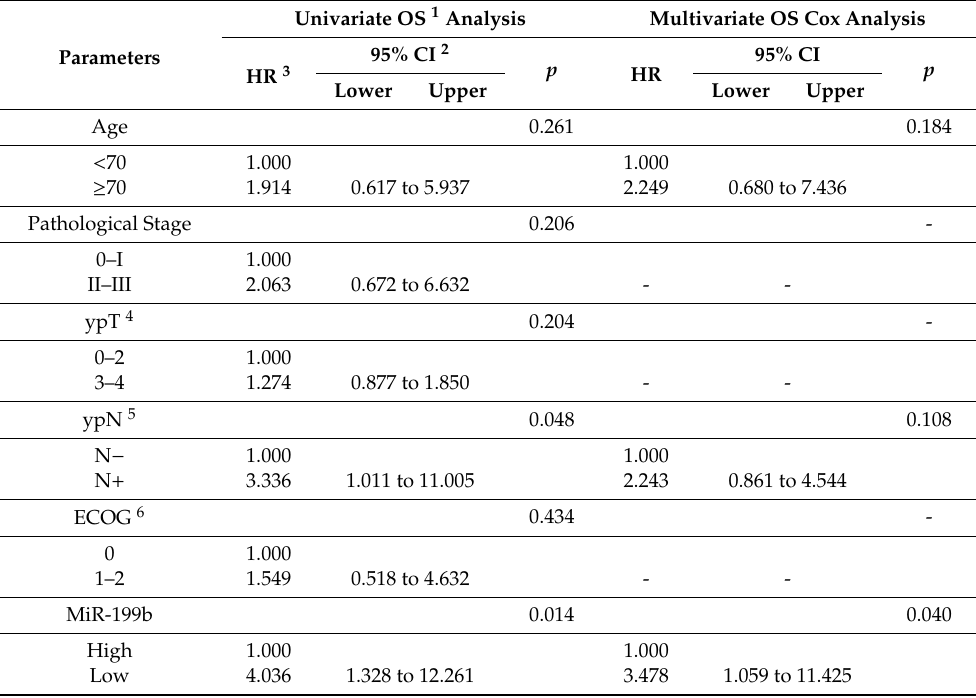
Table 4. Univariate and multivariate Cox analyses in the cohort of 82 LARC patients.